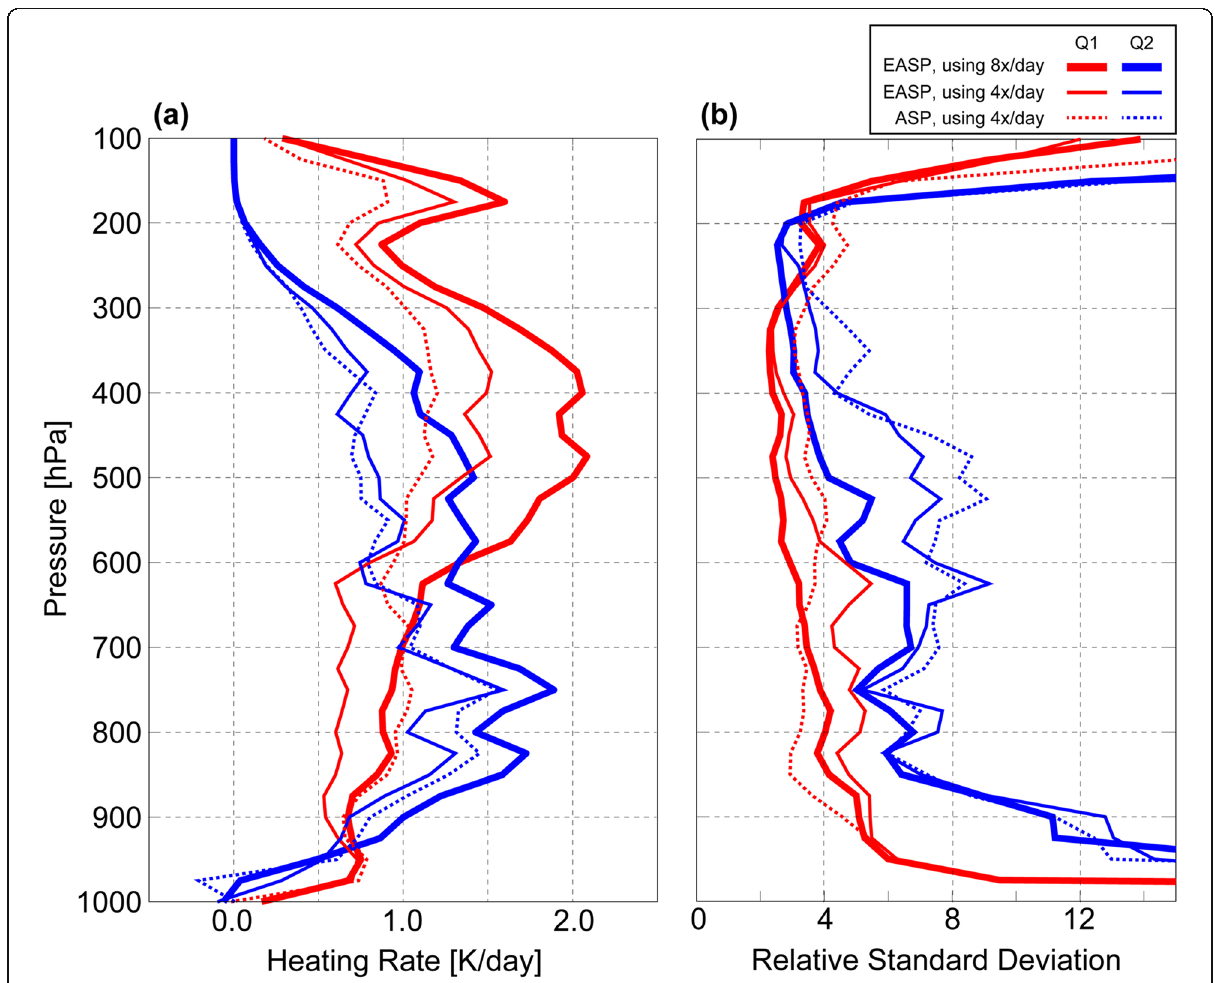
Fig. 4 Vertical profile of a period-averaged Q1 and Q2 , and b relative standard deviation of Q1 and Q2 , obtained by the budget analyses. The averaged periods are EASP and ASP. The results using 3-hourly soundings (8 times/day) and 6-hourly soundings (4 times/day) are shown for